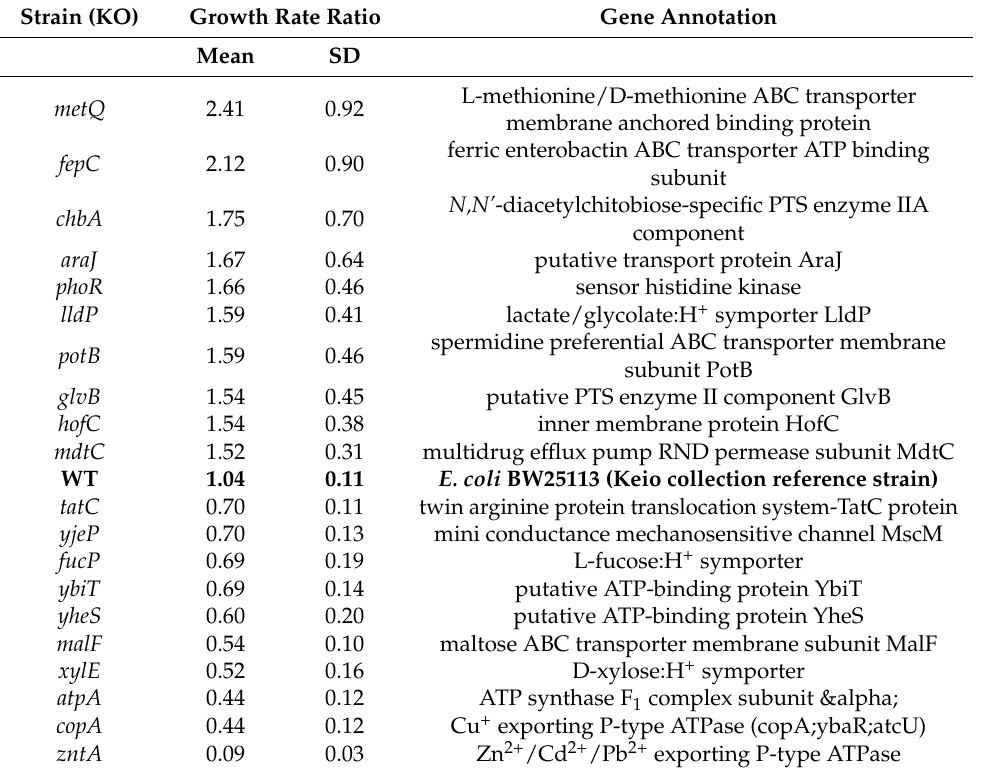
Table 2. Growth rate ratios of the top and bottom ten hits from the subset of the Keio gene knockout collection exposed to pyrithione. E. coli reference strain BW25113 (WT) divides the knockout (KO) strains presenting ratios of growth rates above and below the units. All strains were cultured in parallel in LB with or without 2 µ M pyrithione. Full list available in Table S1. Strain (KO) Growth Rate